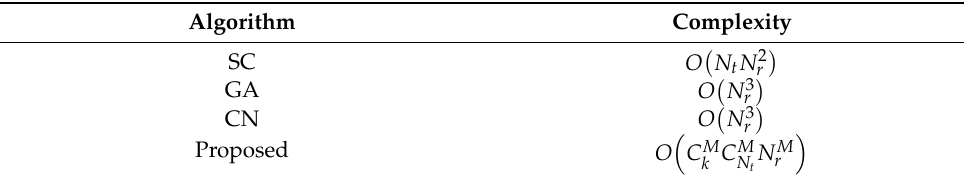
Table 2. Complexity comparison.